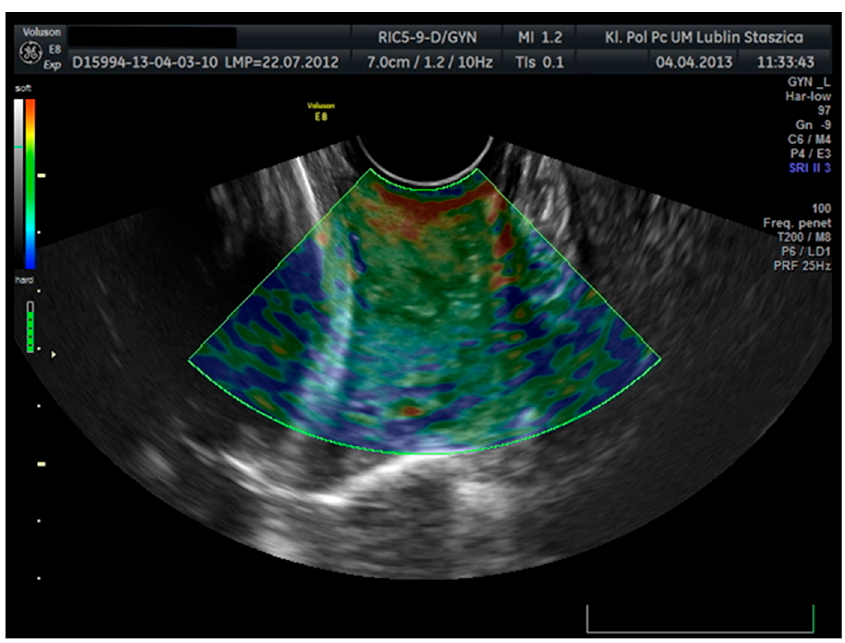
Figure 2. Cervical elastographic assessment. -own source Tissue elasticity distribution calculations in real-time and presented using a color scale—red (soft), blue (hard), and green (medium-hard).